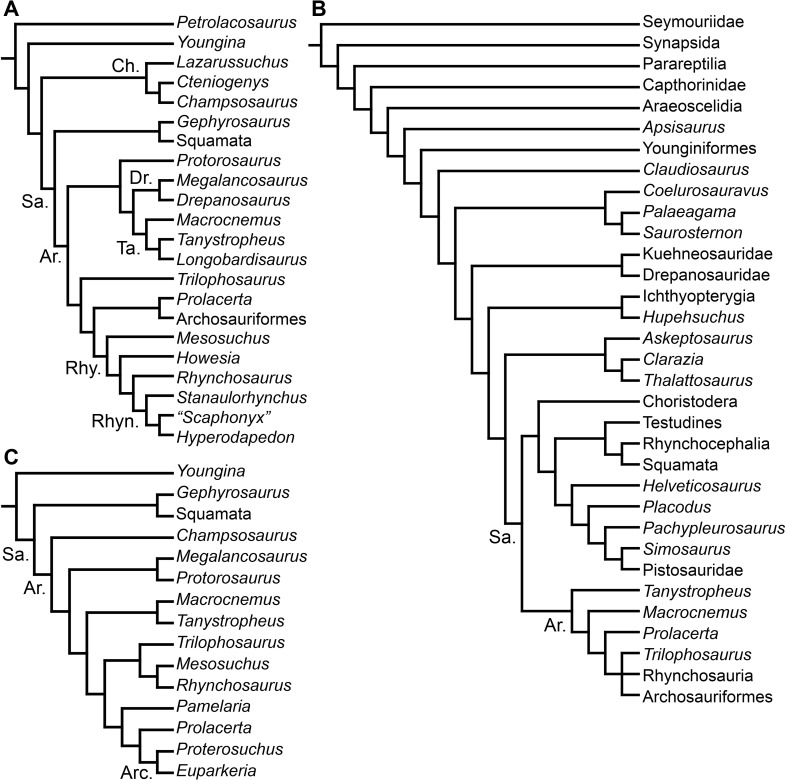
Phylogenetic trees depicting selected previous hypotheses for the higher-level relationships of early archosauromorphs in the period 1998–2009.(A) Dilkes (1998); (B) Müller (2004); and (C) Gottmann-Quesada & Sander (2009). Abbreviations: Ar., Archosauromorpha; Arc., Archosauriformes; Ch., Choristodera; Dr., Drepanosauridae; Rhy., Rhynchosauria; Rhyn., Rhynchosauridae; Sa., Sauria; Ta., Tanystropheidae.